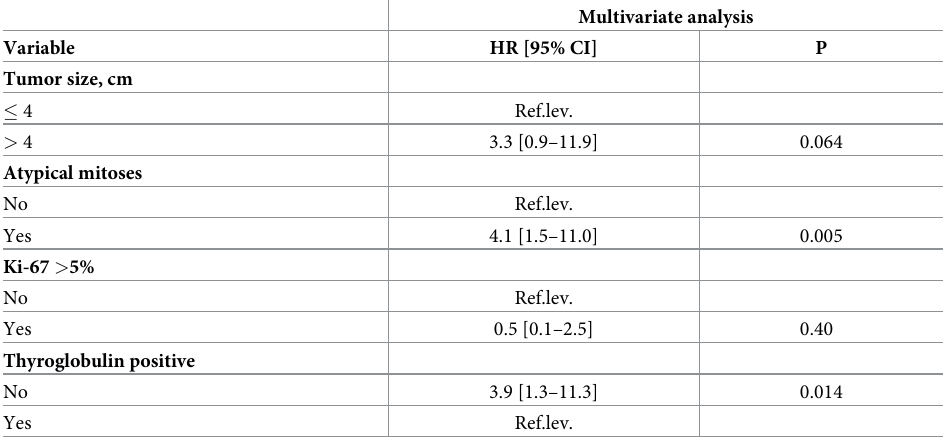
Table 5. Multivariate analysis of DSS in PDTC patients performed using the Cox proportional-hazards model.